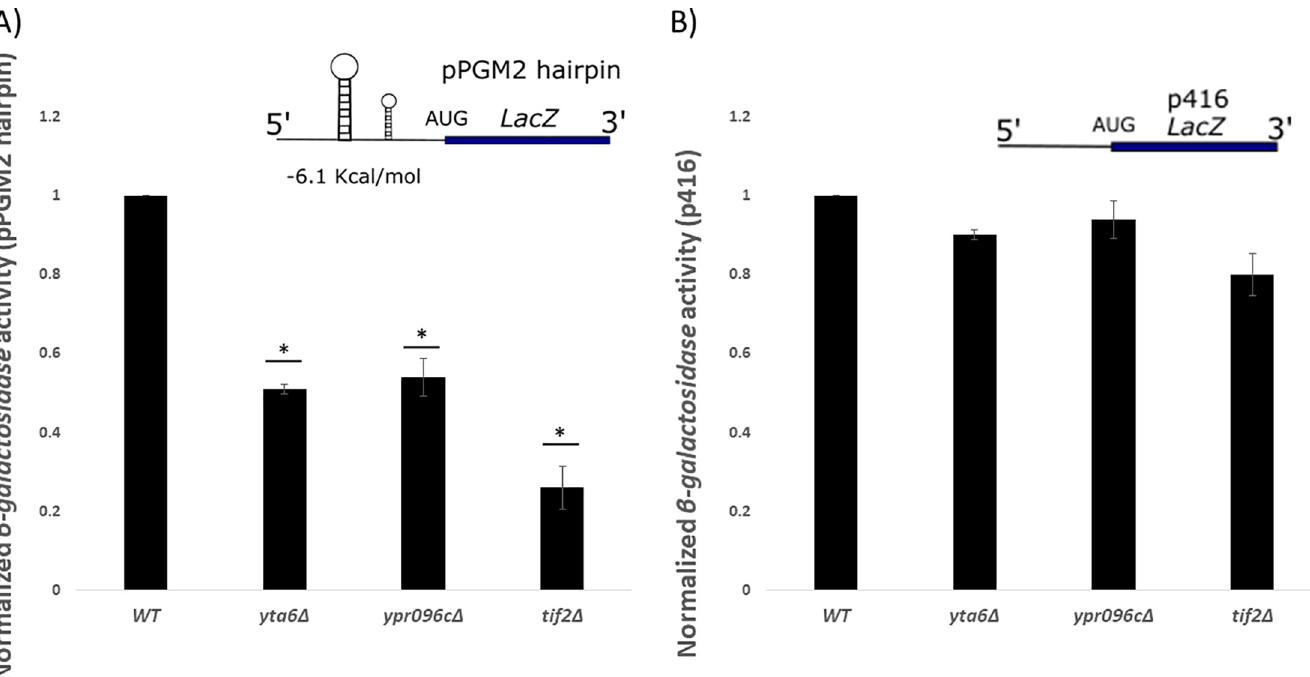
Fig 4. β -galactosidase expression analysis in different yeast strains. Activities from β -galactosidase mRNAs that carry 5’-UTR of PGM2 mRNA (pPGM2) (A) upstream of LacZ reporter was reduced in yta6 Δ and ypr096c Δ strains; tif2 Δ was used as a positive control. Strains carrying low complexity regions upstream of LacZ reporters p416 (B) did not show as significant reductions in β -galactosidase activity. Values are normalized to that for WT which resulted in average β -galactosidase values of 38.1U and 407.5U for pPGM2 and p416 constructs, respectively. Each experiment was repeated at least three times (n � 3) and error bars represent standard deviation. � represent statistically significant results ( P -value � 0.05) compared to the WT. t-test analysis ( P -value � 0.05) was used to compare differences. The insets represent schematic reporter mRNA structures.